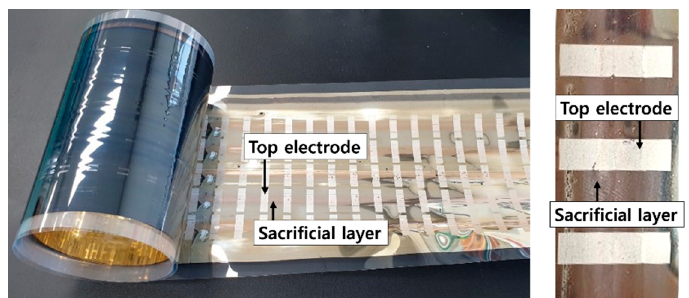
Figure 6. Roll-to-roll gravure printed top electrode on a PET roll ( left ); and enlarged image ( right ).